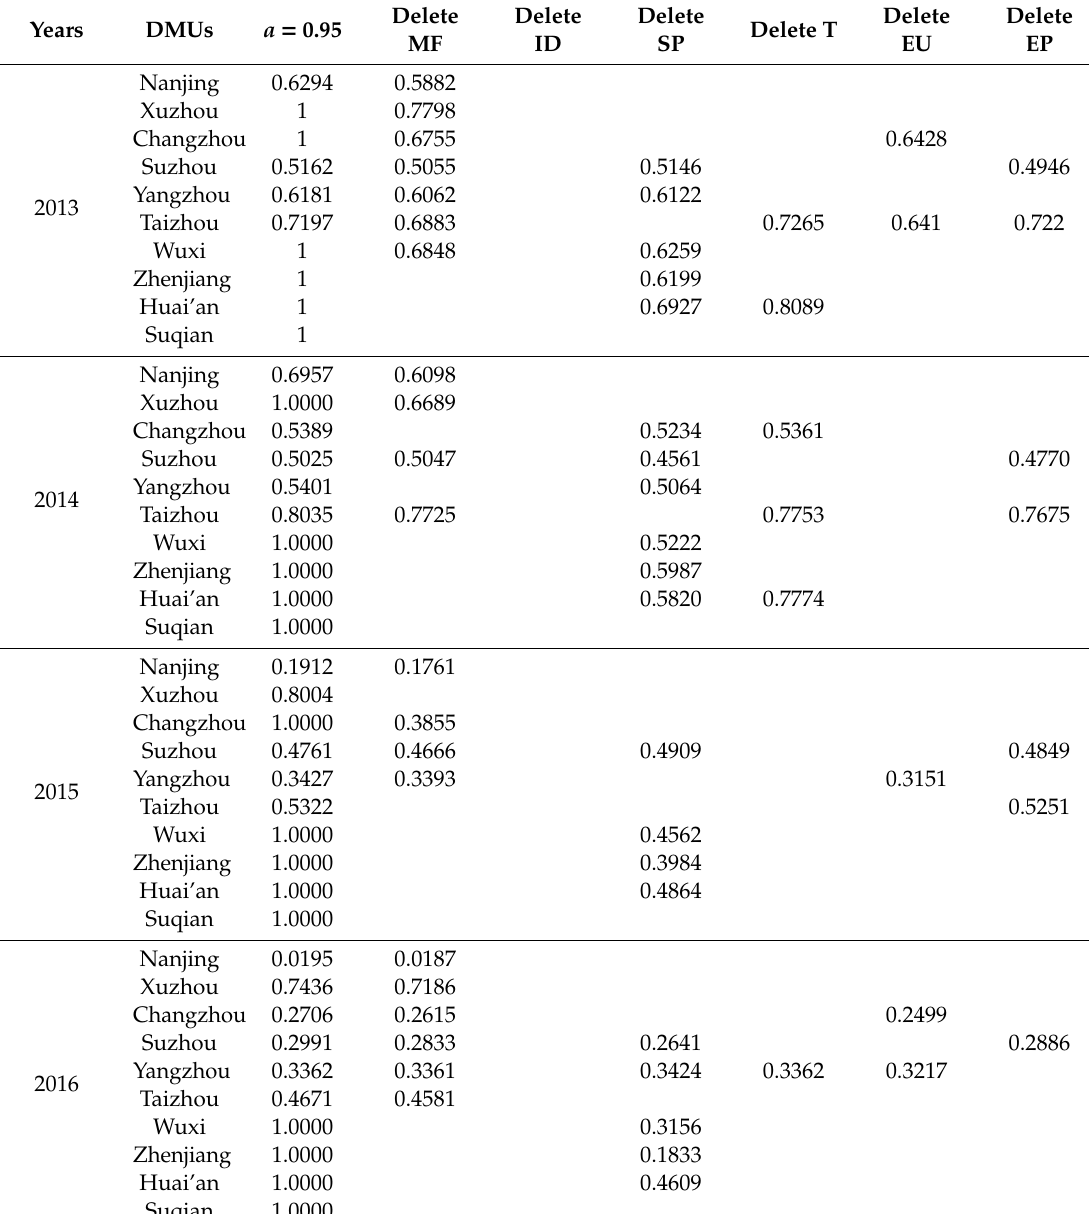
Table A12. The changes of stochastic e ffi ciency value by deleting grouping input variables in Inland Area ( α =